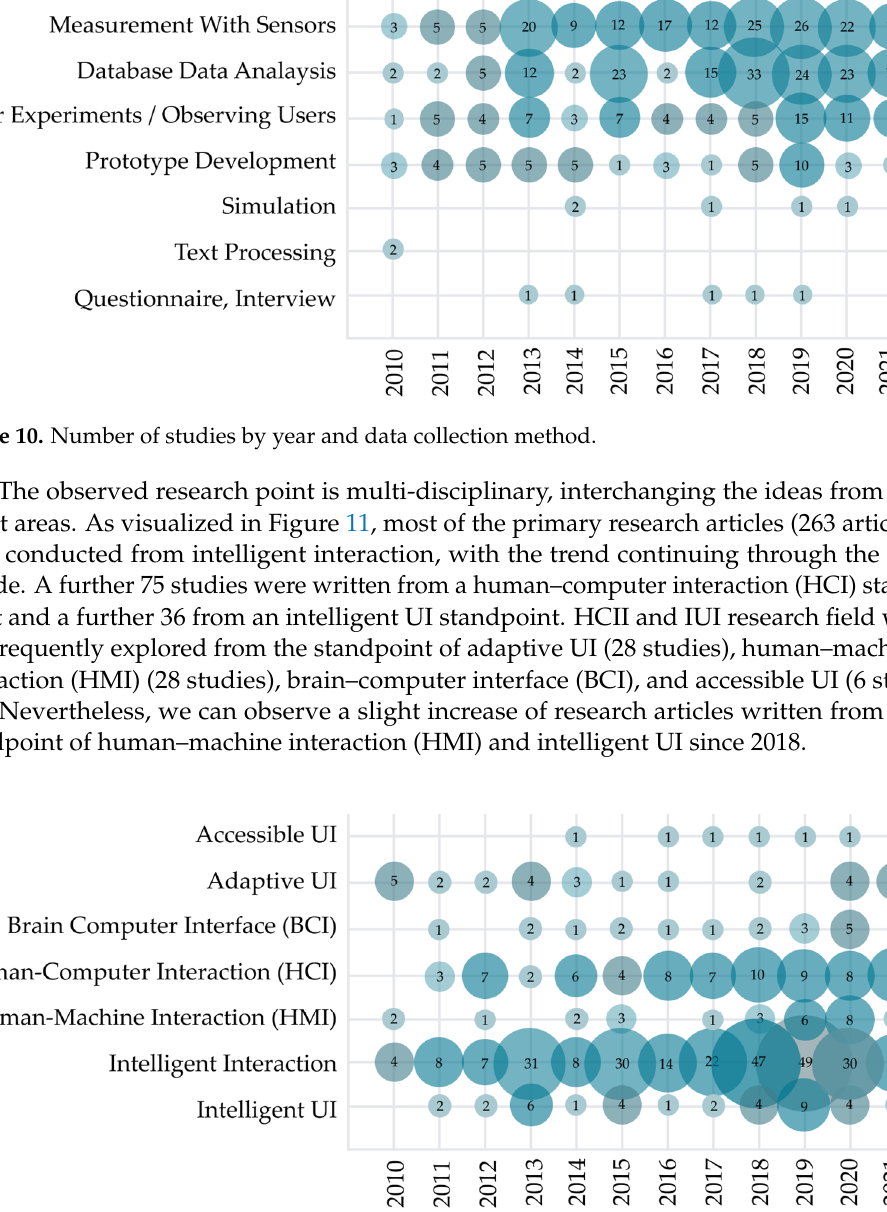
Figure 12. Distribution of HCII solutions’ development phases according to the research standpoint. 4.3. Sensors Technology and Intelligent Methods in the Development and Evaluation of HCII Solutions Figure 13 shows the correlation between the main aim of intelligent recognition and the standpoint of the research. As we have already discussed in previous sections, most of the analyzed research has been conducted from an intelligent interaction standpoint. As shown in Figure 13, this research is mostly focused on emotion recognition (96 primary studies), gesture recognition (44 studies), and facial expression recognition (32 studies). A similar trend in recognition focus can be observed in papers from other standpoints as well. Overall, analyzed studies from the HCII and IUI fields have primarily focused on intelligent recognition of emotion (129 studies), gestures (87 studies), and facial expres- sions (45 studies). A slightly different trend can be visible in the research from an intelli- gent UI and adaptive UI standpoint, where we can observe a focus on behavior recogni- tion along with the previously mentioned recognition trends.